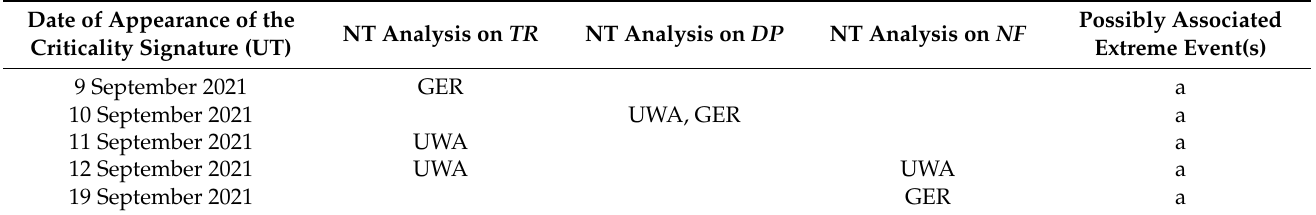
Table 9. Results of the NT analysis for the 2021 Crete EQs. UWA and GER denote the station where the corresponding criticality has been